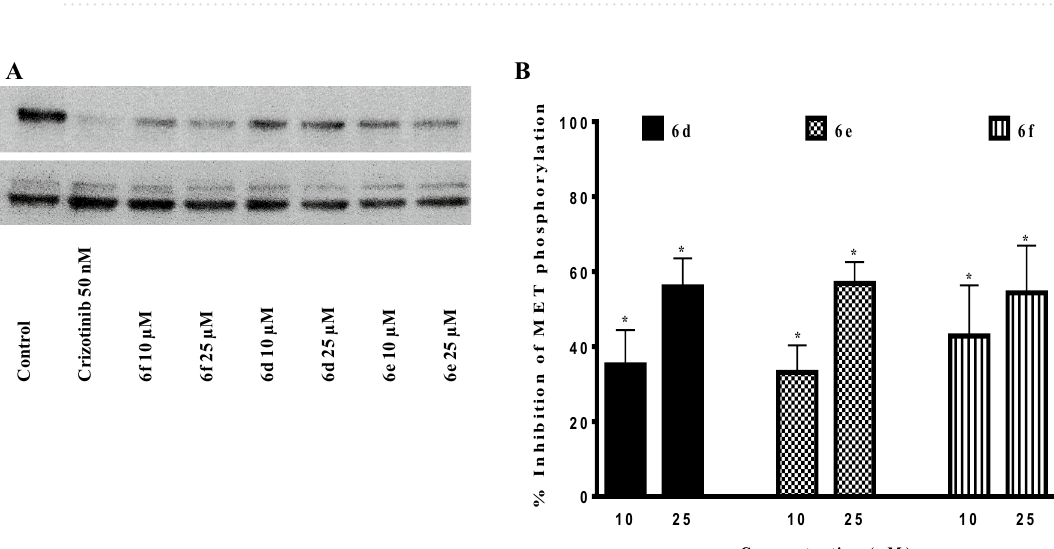
Figure 4. Effect of synthesized derivatives on c-Met phosphorylation in AsPc-1 cancer cells. ( A ) AsPC-1 cells were seeded in 6-well plates and treated with indicated concentrations of synthesized derivatives for 3 h and analyzed by immunoblotting. ( B ) The inhibitory effects of 6f , 6d and 6e compounds were quantified based on alterations of band intensities. *The difference with control was statistically significant ( p < 0.05). Values represent the mean ± S.E.M. of 3–6 separate